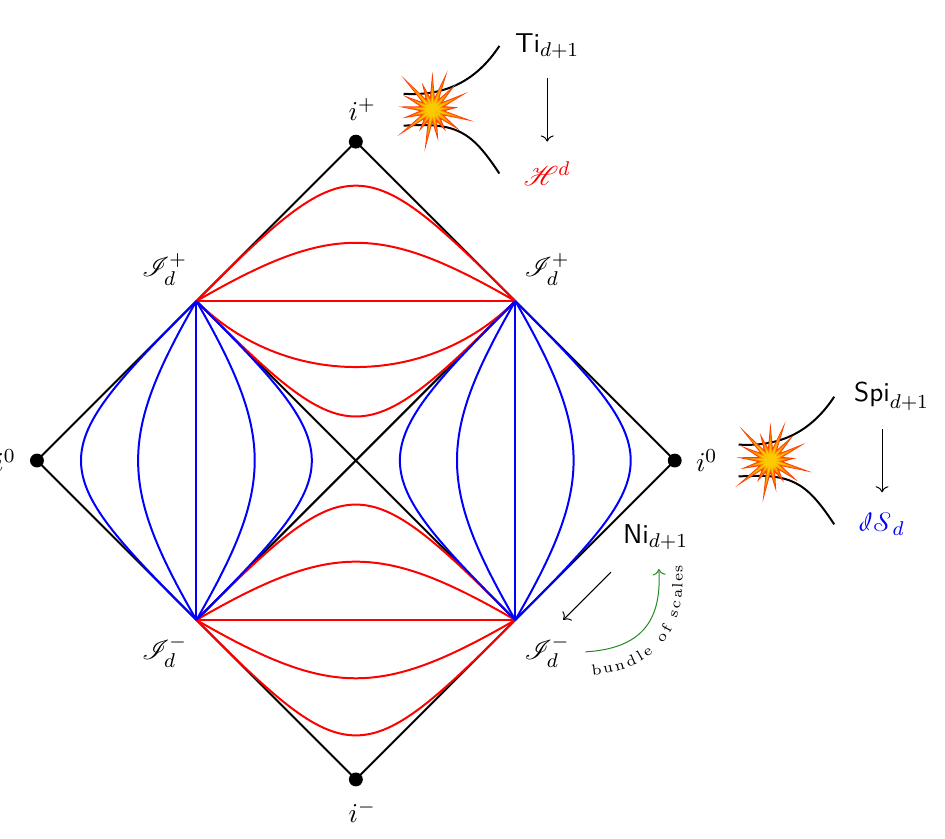
Figure 1 . The Penrose diagram of Minkowski spacetime M with its hyperbolic slicing. We have also illustrated how Ti and Spi arise as the blow-ups of, respectively, timelike and spacelike infinities, while Ni fibers over I and can be understood as the bundle of scales of the conformal carrollian structure of I